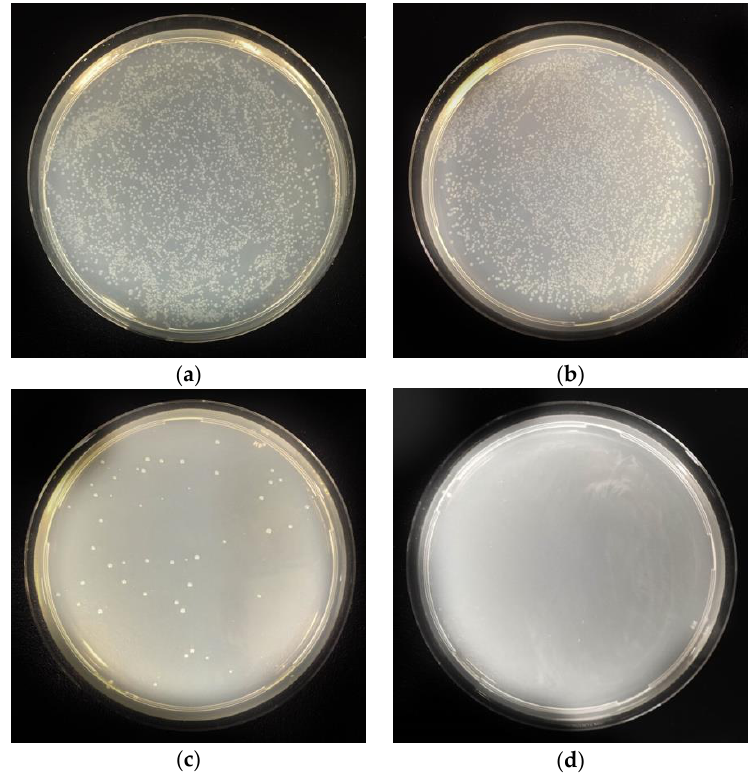
Figure 6. Agar plates of sample from the ( a ) Bacterial control; ( b ) PAN sample control; ( c ) PAN–AgNP sample (after 30 min); ( d ) PAN–AgNP sample (after 60 min).